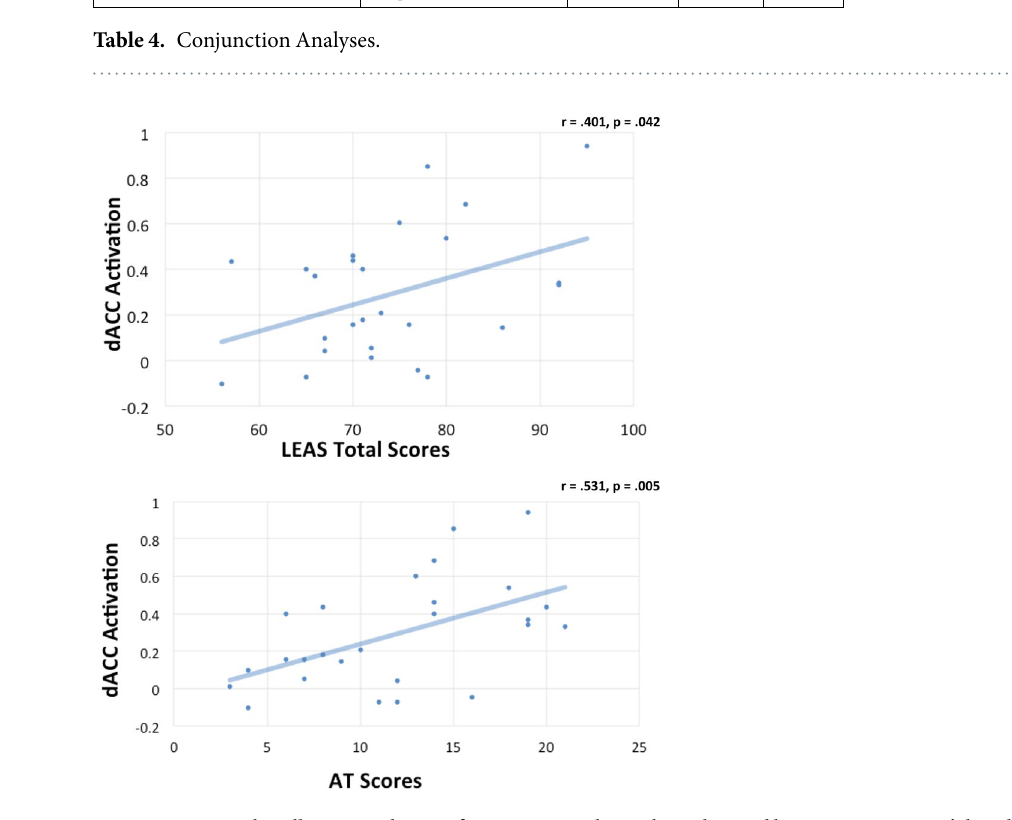
Figure 3. Scatterplots illustrating the significant positive relationships observed between participants’ dorsal anterior cingulate cortex (dACC) activation in the “Emotion > Image” contrast and two measures of their emotional awareness. The top panel illustrates this relationship with Levels of Emotional Awareness Scale (LEAS) Total scores. The bottom panel illustrates this relationship with scores on the “animations task” (AT) described in the main